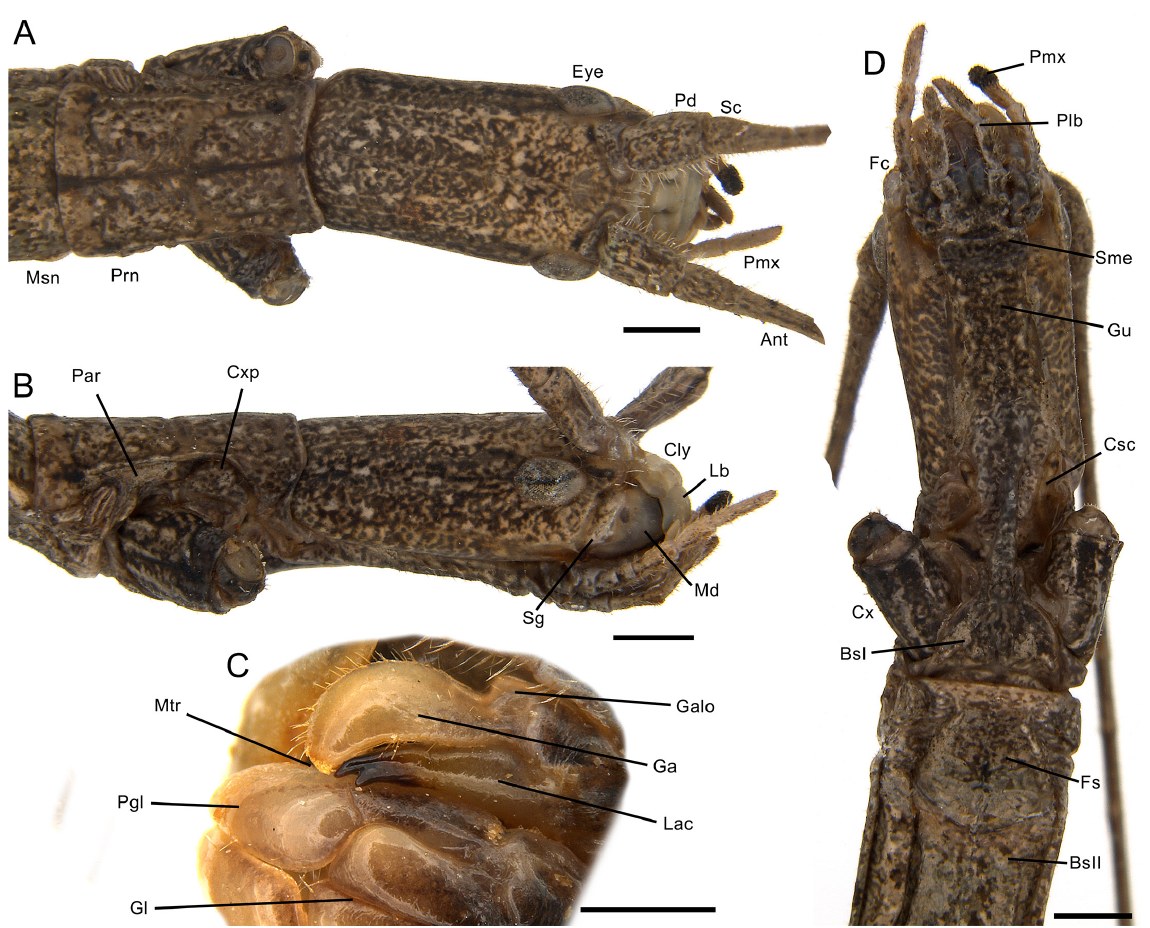
Fig. 48. Arumatia diamante Ghirotto gen. et sp. nov., holotype, ♀ (MZUSP V0650), head and prothorax morphology. A . Head and prothorax in dorsal view. B . Head and prothorax in lateral view. C . Left maxilla in ventral (external) view. D . Head and prothorax in ventral view. Abbreviations: Ant = antennomere; BsI-II = pro- and mesothoracic basisterna; Cly = clypeus; Csc = cervical sclerite; Cx = coxa; Cxp = coxopleurite; Eye = compound eye; Fc = frontal convexity; Fs = prothoracic furcasternite; Ga = galea; Galo = galealobulus; Gl = glossa; Gu = gula; Lac = lacinia; Lb = labrum; Md = mandible; Msn = mesonotum; Mtr = microtrichia; Par = paranota; Pd = pedicellus; Pgl = paraglossa; Plb = labial palpus; Pmx = maxillary palpus; Prn = pronotum; Sc = scapus; Sg = subgena; Sme = submentum. Scale bars: A–B, D = 1 mm; C = 0.5